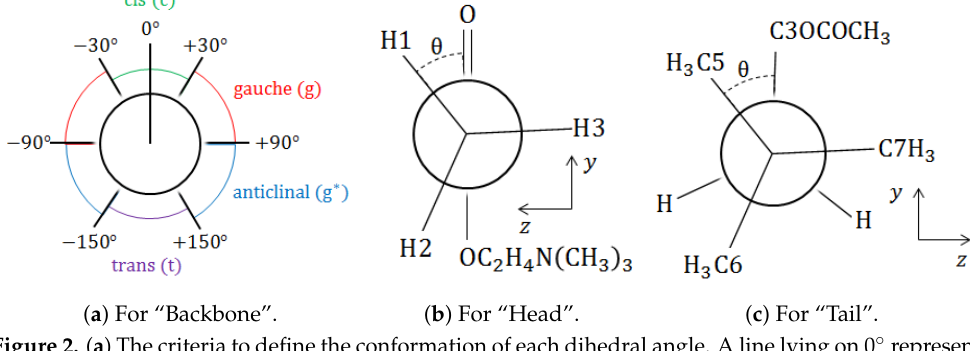
Figure 2. ( a ) The criteria to define the conformation of each dihedral angle. A line lying on 0 ◦ represents the bond of the first two atoms describing the dihedral angle. Newman projections ( b ) along C2–C1 and ( c ) along N–C4. For Figure 2b,c, θ ∼ = 0 ◦ means eclipsed conformation and θ ∼ = 60 ◦ means staggered